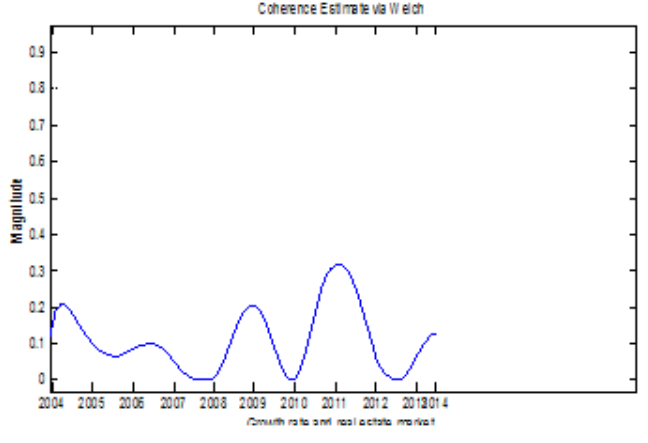
Figure 3. DCF of Economic Growth Rate and Real Estate Market